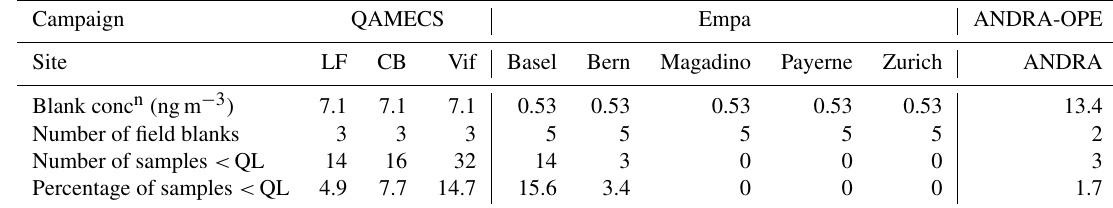
Table 3. Cellulose concentrations derived from blank filters to derive the quantification limit (QL) for each site. Campaign QAMECS Empa ANDRA-OPE Site LF CB Vif Basel Bern Magadino Payerne Zurich ANDRA Blank conc n (ngm − 3 ) 7.1 7.1 7.1 0.53 0.53 0.53 0.53 0.53 13.4 Number of field blanks 3 3 3 5 5 Number of samples < QL 14 16 32 14 3 0 0 0 3 Percentage of samples < QL 4.9 7.7 14.7 15.6 3.4 0 0 0 1.7